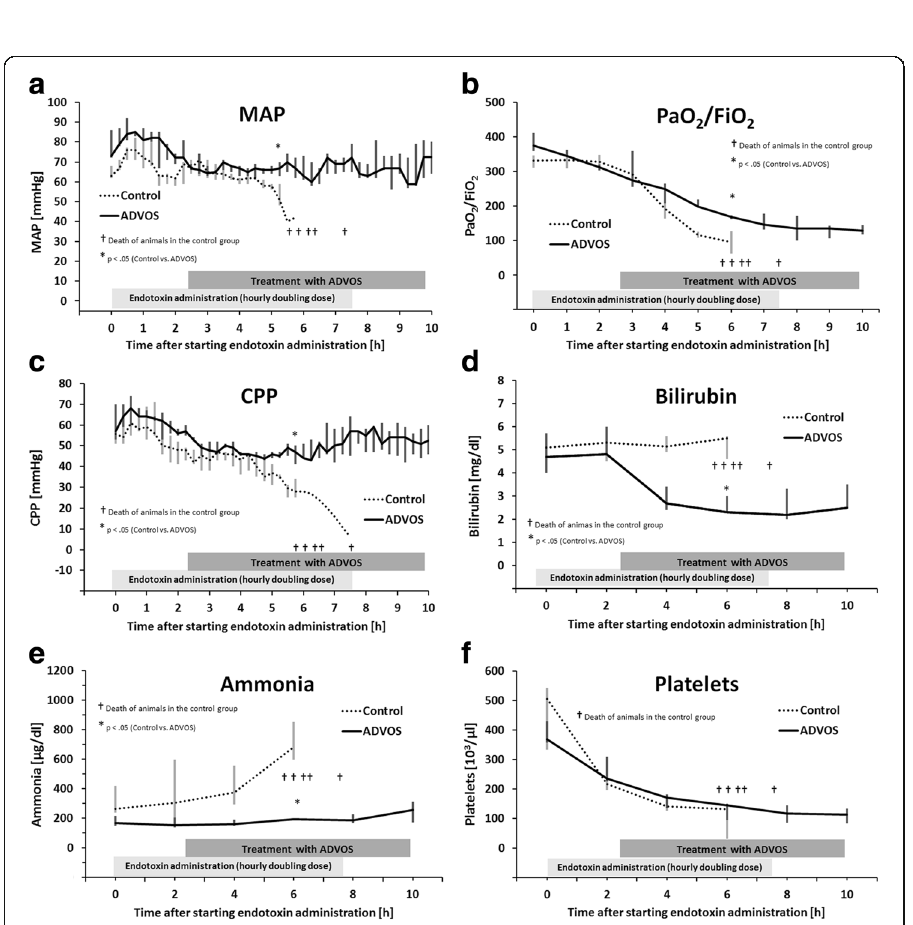
Fig. 4 Effects of the ADVOS in treatment in SOFA score related surrogate markers from T0 to T10 after endotoxin administration. Each graphic shows the median and IQR. Labels for ADVOS treatment and endotoxin administration are placed in a way that shows the duration of each procedure. a Mean arterial pressure. b Ratio of oxygen arterial oxygen/fraction of inspired oxygen. c Cerebral perfusion. d Bilirubin. e Ammonia. f Platelet